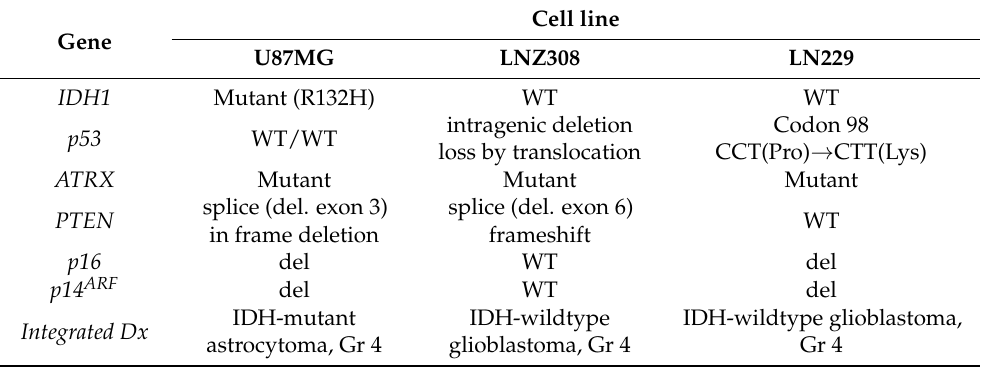
Table 1. Molecular characterization of the glioma cell lines by combining our experiments and